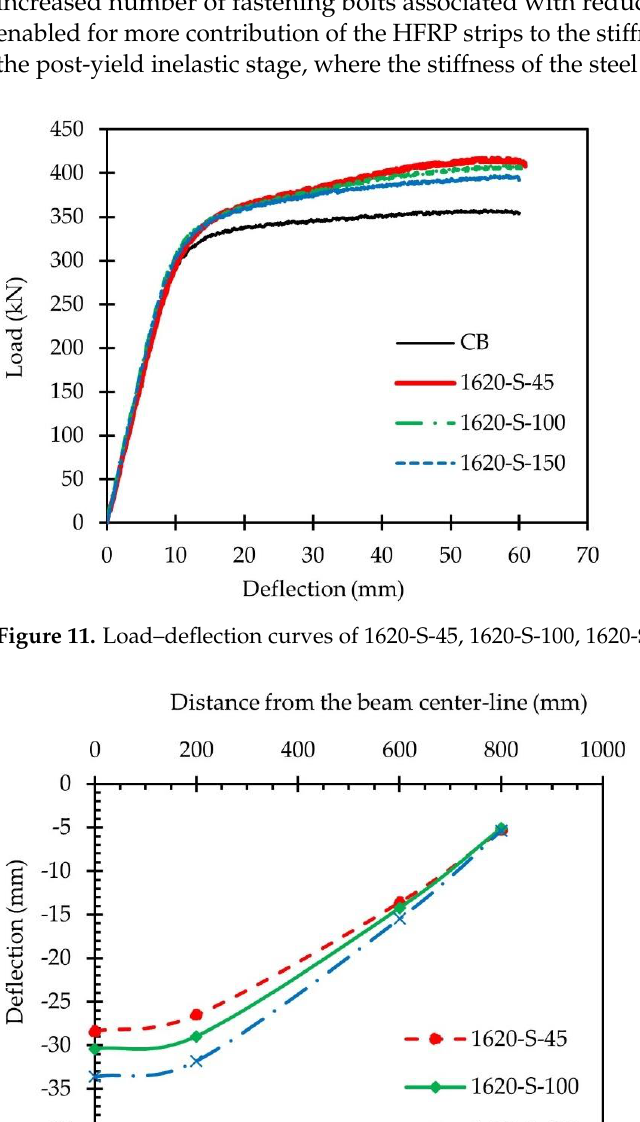
Figure 12. Deflection profiles along the spans of 1620-S-45, 1620-S-100 and 1620-S-150 at 380 kN.